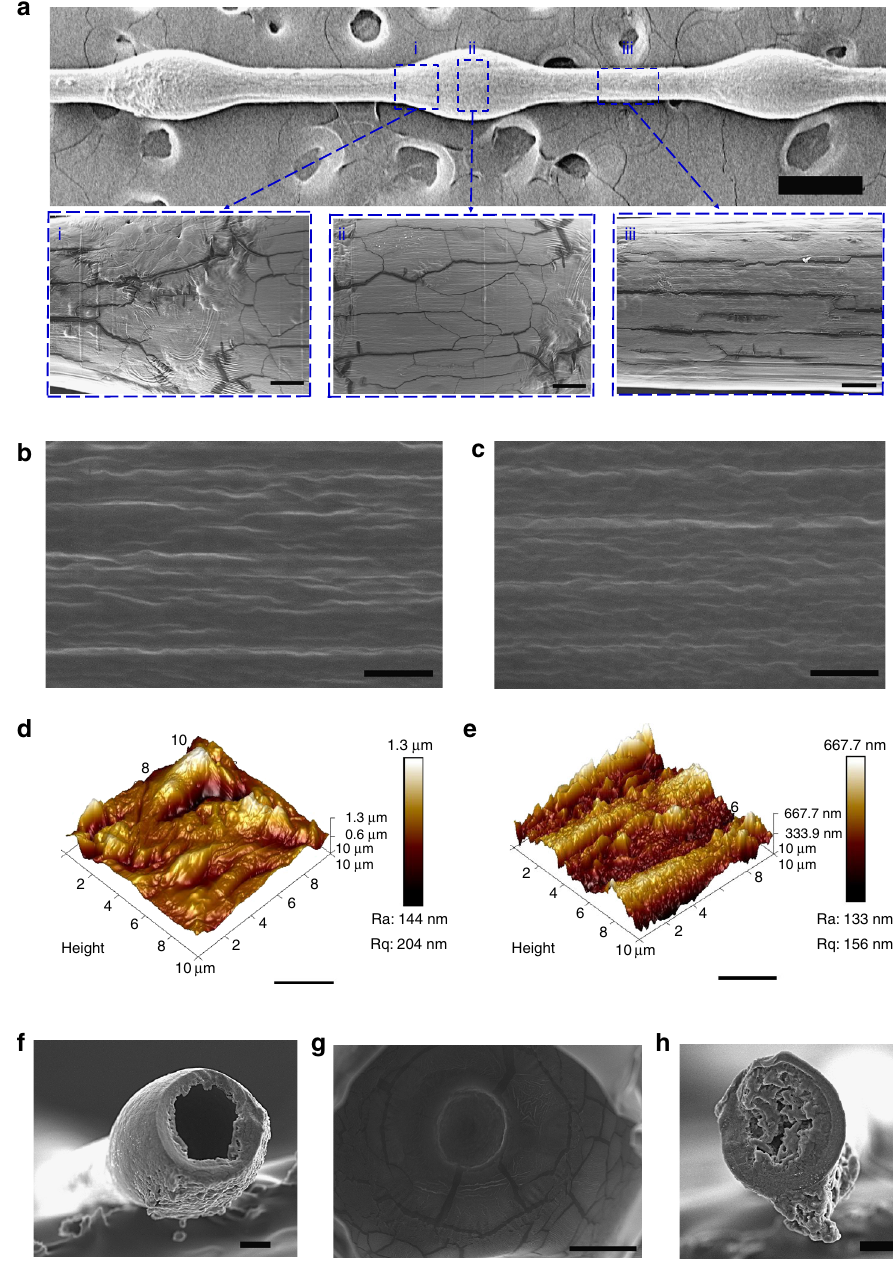
Fig. 2 The morphology of cavity-micro fi bers. The SEM images showing ( a ) the dehydrated cavity-micro fi ber; ( b ) the nanostructures of knot part of cavity- micro fi ber; ( c ) the nanostructures of joint part of cavity-micro fi ber; AFM image showing roughness and nanostructures of ( d ) the knot part and ( e) joint part of the cavity-micro fi ber; SEM images showing ( f , g ) the hollow cavity of the knot; ( h ) the solid cross section of the joint part for cavity-micro fi ber. Scale bars, 300 μ m in ( a ), 30 μ m in ( a , i – iii), 2 μ m in ( b – e) and 50 μ m in ( f –